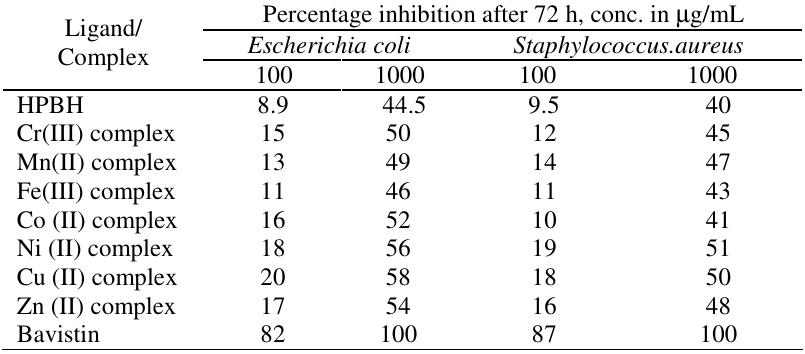
Table 2. Fungicidal activity of the ligand and its metal